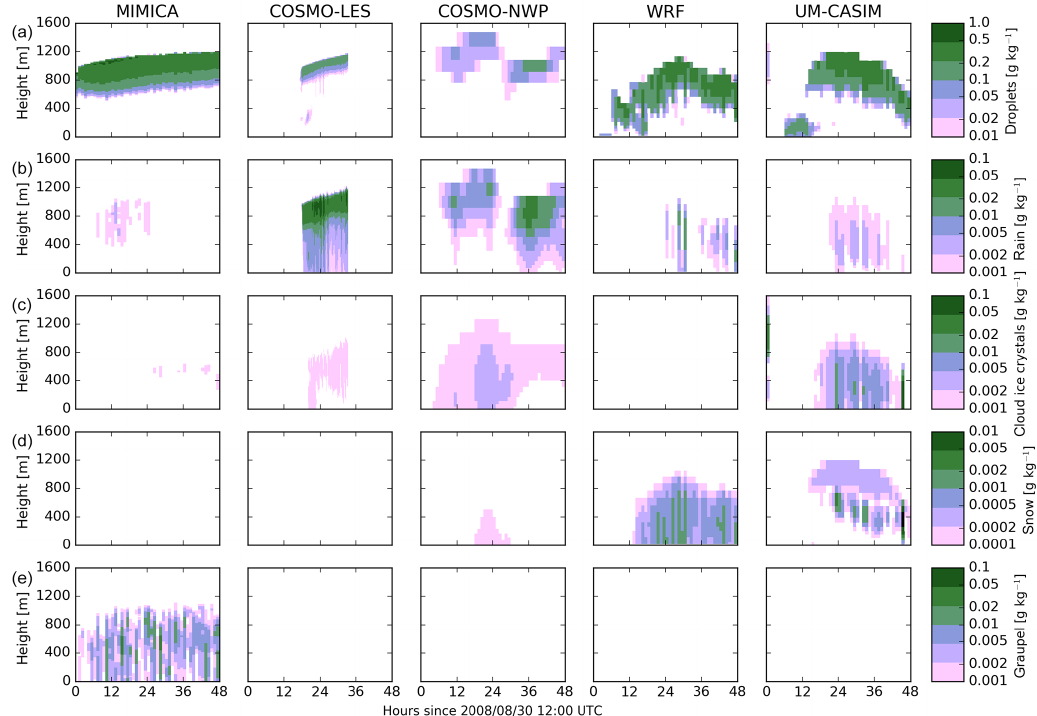
Figure 12. Cloud mass mixing ratios in the simulations with a prescribed CDNC of 30cm − 3 and a prescribed ICNC of 0.2L − 1 (CDNC30_ICNC0p20). (a) Mass mixing ratios of cloud droplets, (b) mass mixing ratios of rain, (c) mass mixing ratios of cloud ice crystals, (d) mass mixing ratios of snow, and (e) mass mixing ratios of graupel. Results are shown (left to right) from the MIMICA, COSMO-LES, COSMO-NWP, WRF, and UM-CASIM models. Note that WRF does not possess a graupel category.